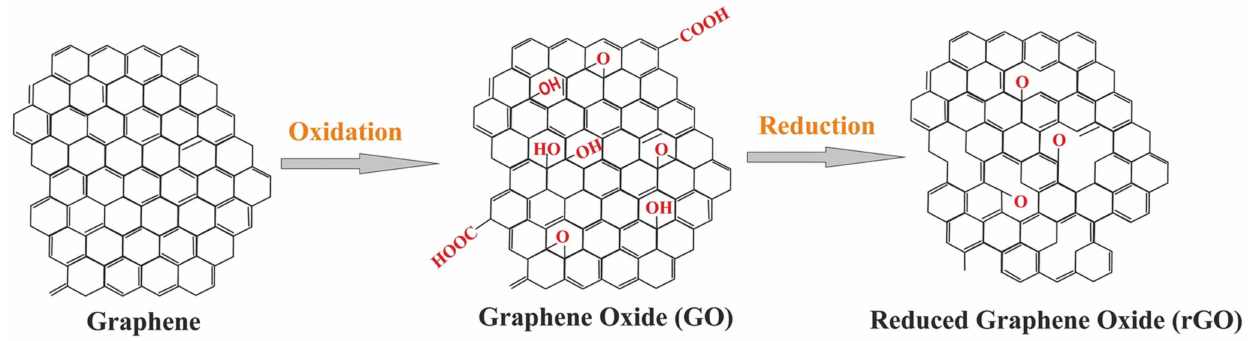
Figure 5. Chemical structure of graphene, GO and rGO. Reproduced with permission from [127] under Creative Commons license (http://creativecommons.org/licenses/by/4.0/, accessed on 15 De- cember